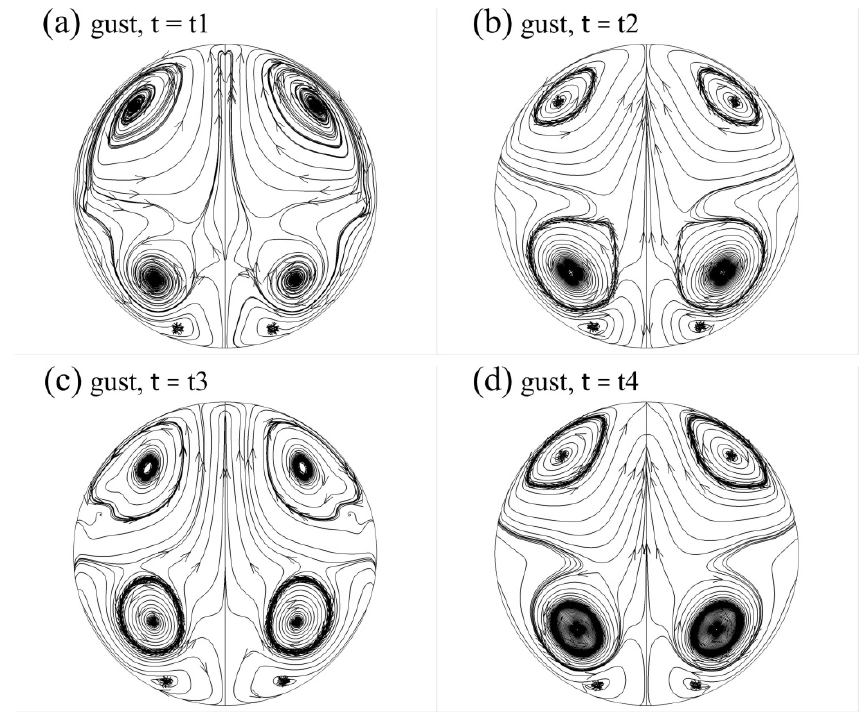
Figure 23. Streamline distributed at the AIP at four instances of the gust case of f = 100 Hz and (cid:101) u g = 8